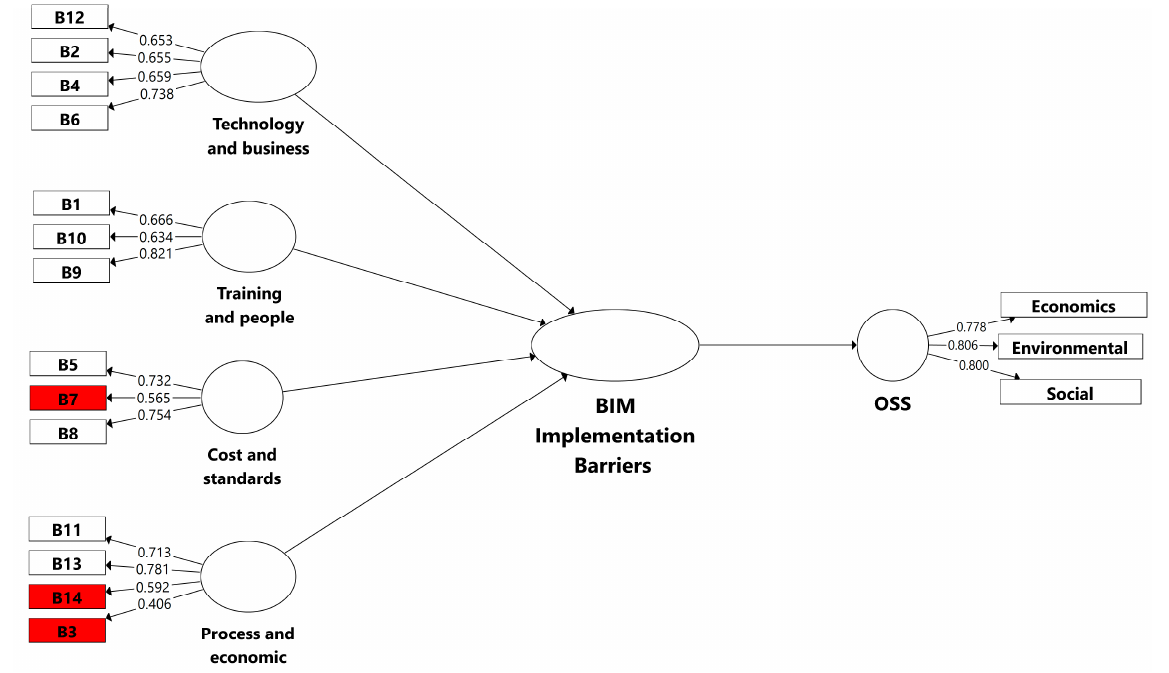
Figure 3. The PLS model.